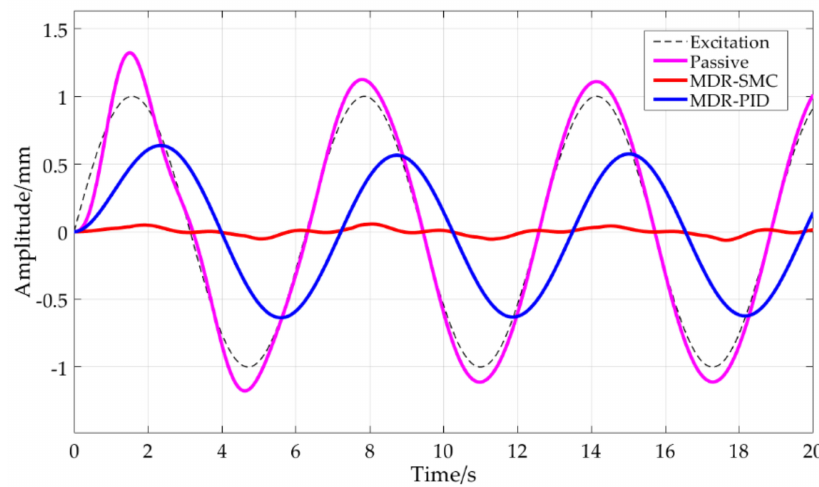
Figure 18. Comparison of the SMC with MRD, PID with MRD, and the passive system under excitation of a sinusoidal signal with an amplitude of 1 mm and a frequency of 1 rad/s.